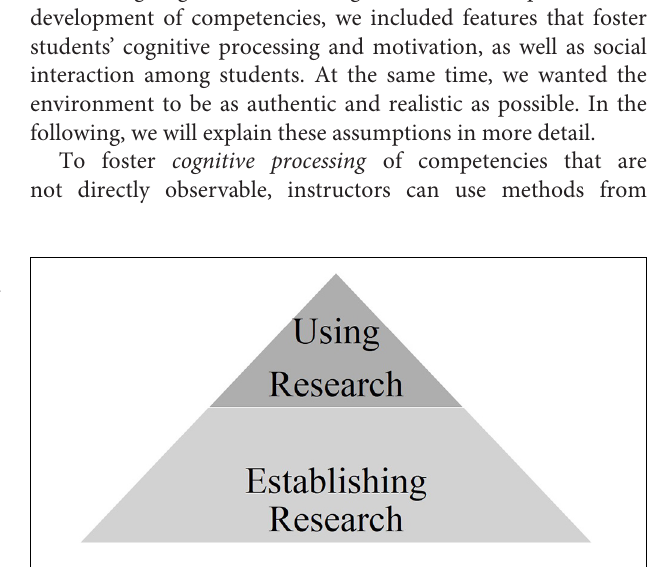
FIGURE 1 | Relation of using and establishing